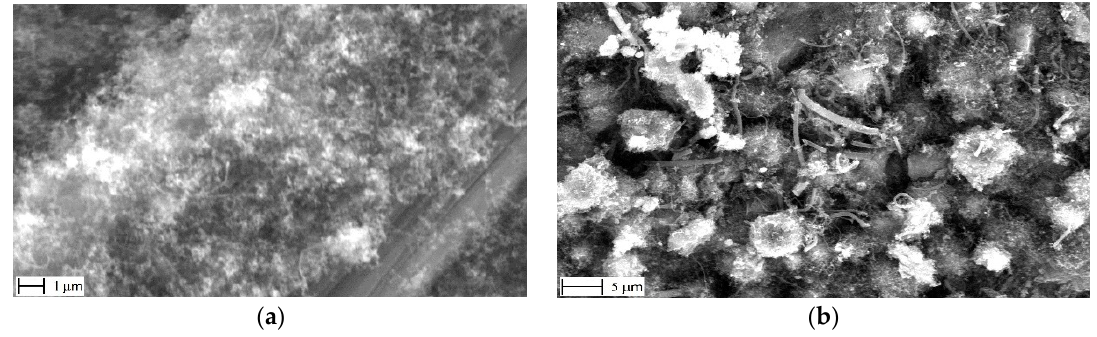
Figure 4. CNF “forests” after a relatively low (0.18 wt %, a ) or high (2.9 wt %, b ) Ni loadings.